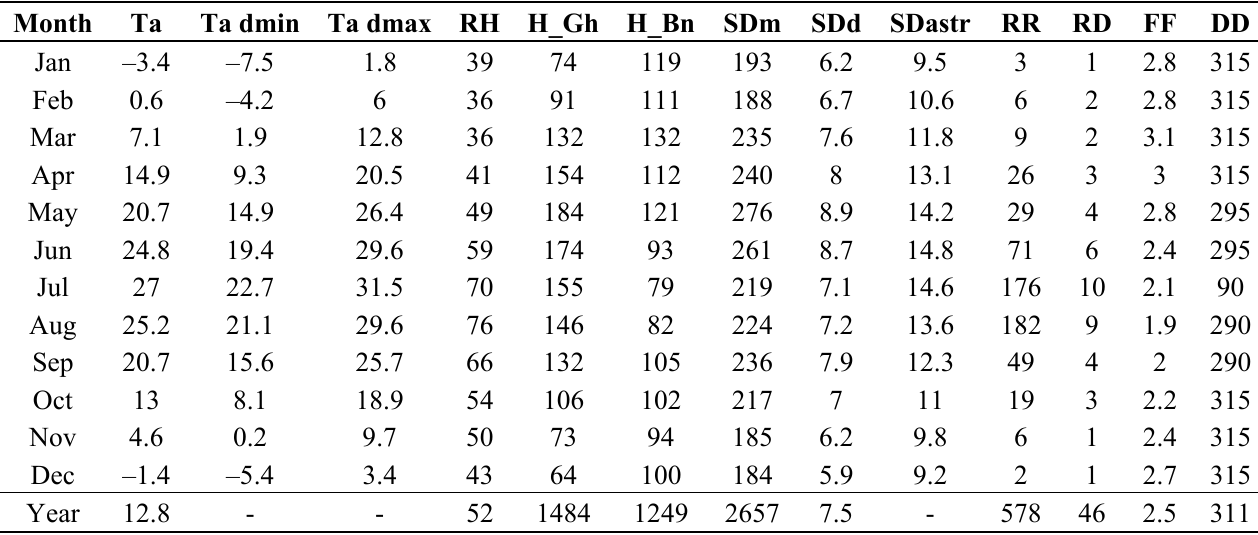
Table 2. Table of Beijing (39.5°N) climate data summary (MeteonormV6.1 data period: